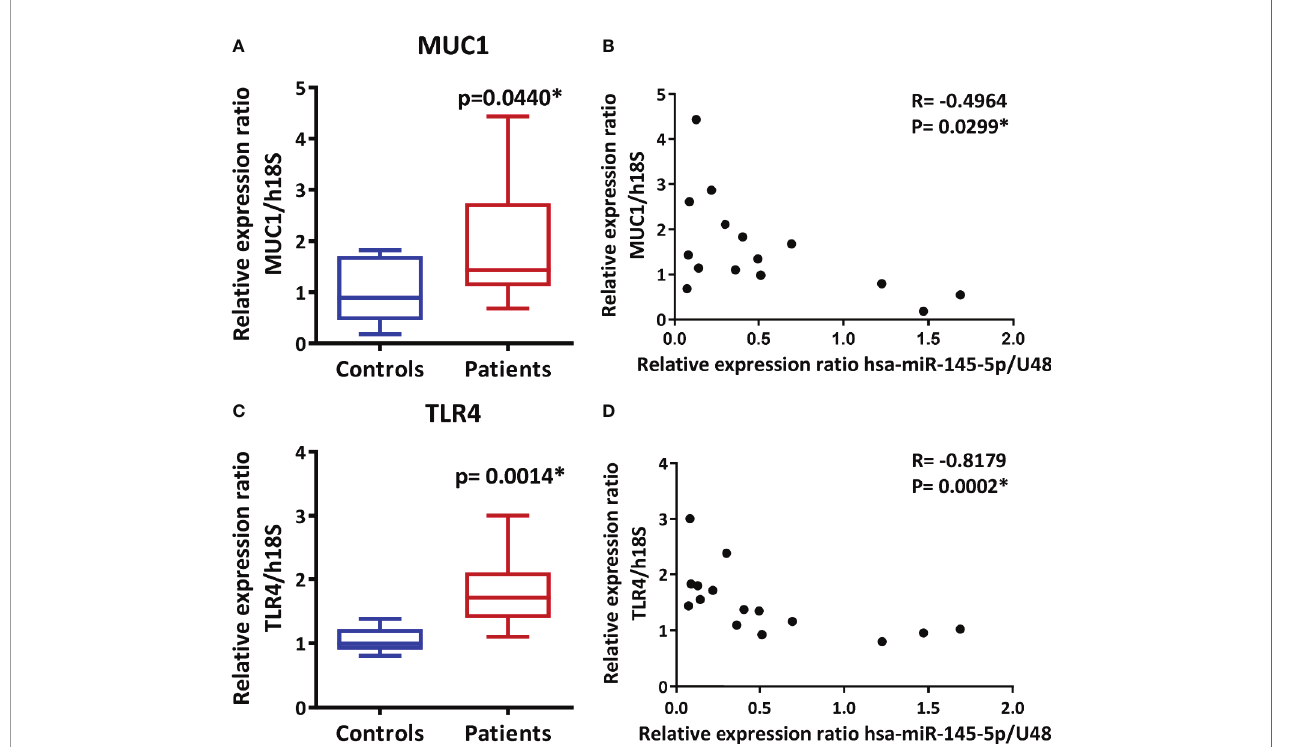
FIGURE 3 | MUC1 and TLR4 are overexpressed in LSG from SS-patients and inversely correlate with hsa-miR-145-5p. (A) MUC1 transcript levels in SS-patients and control subjects. h18S was used as a housekeeping gene. (B) Spearman correlation between hsa-miR-145-5p and MUC1 mRNA levels in SS-patients and controls. (C) TLR4 transcript levels in SS-patients and control subjects. h18S was used as a housekeeping gene. (D) Spearman correlation between hsa-miR-145- 5p and TLR4 mRNA levels in SS-patients and controls. Data are representative of at least three independent measurements. (*) p-value ≤ 0.05 was considered signi fi